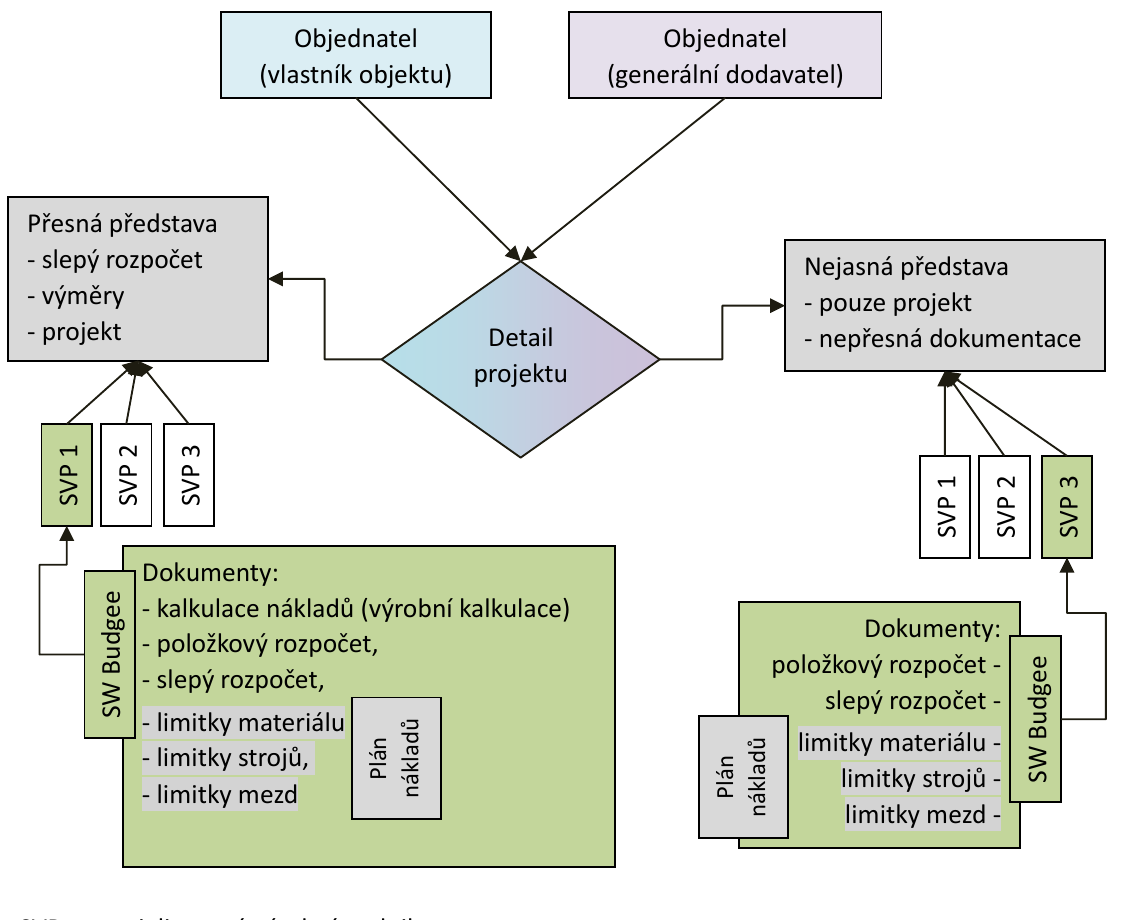
Figure 1: Pozice nasazení specializovaného SW nástroje (zdroj: